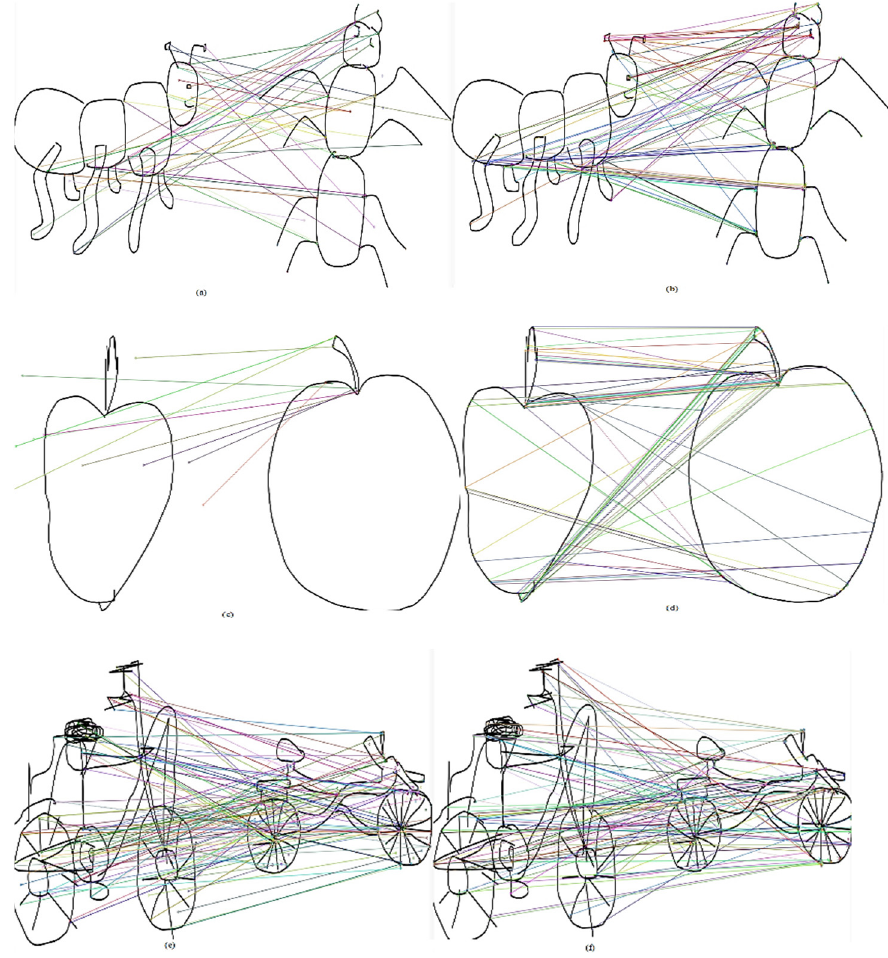
Figure 20. Matched points of ( a ) 4th pair for SIFT, ( b ) 4th pair for ORB, ( c ) 5th pair for SIFT, ( d ) 5th pair for ORB, ( e ) 6th pair for SIFT, and ( f ) 6th pair for ORB.